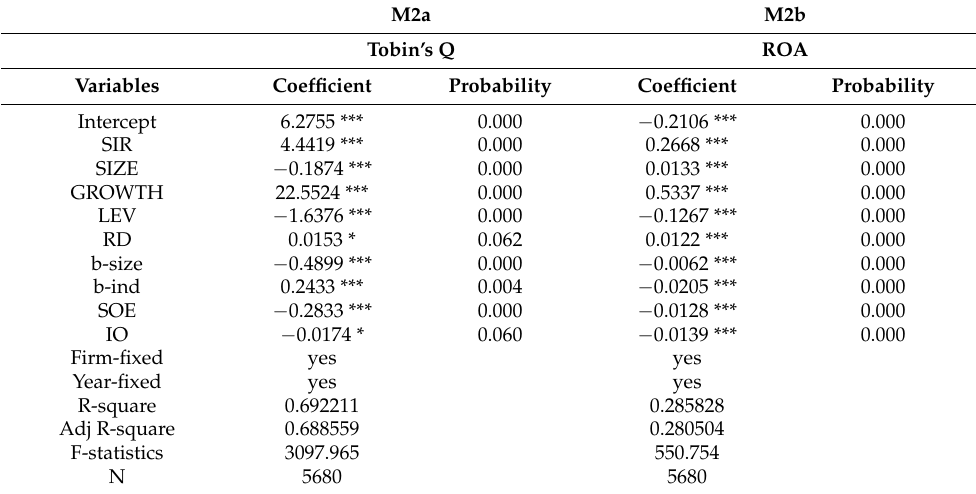
Table 6. Short-selling propensity and firm value.